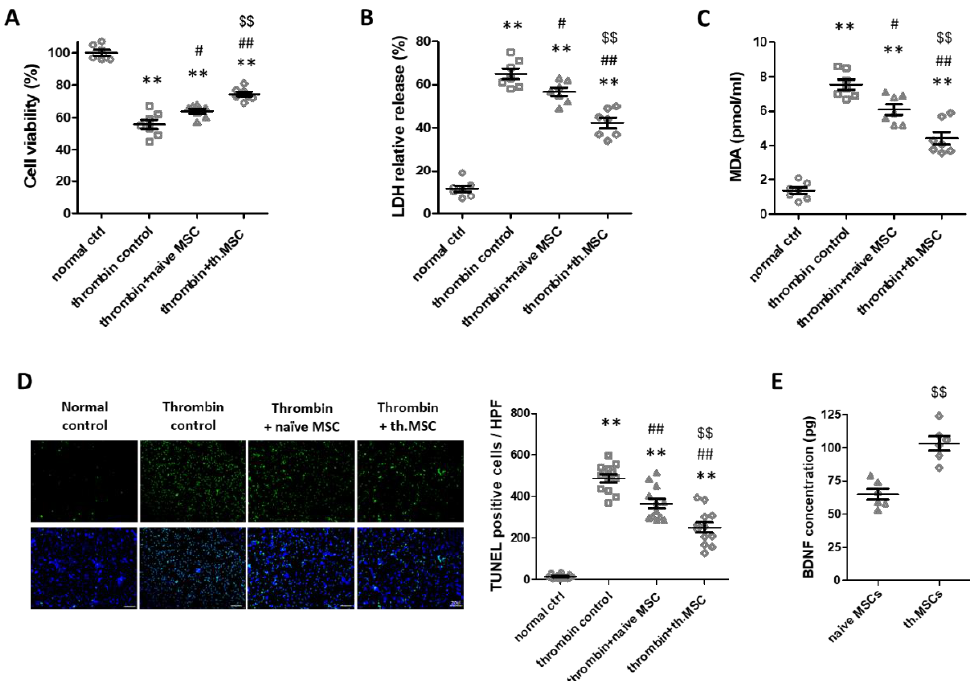
Figure 1. Effect of thrombin preconditioning on the neuroprotective efficacy of MSCs in the in vitro thrombin-induced neuronal injury model. ( A – C ) Cell viability, expressed as the relative prolifera- tion rate (%) to the normal control, cytotoxicity, expressed as the relative LDH level, MDA level, ( n = 7/group) and ( D ) the number of TUNEL-positive cells captured using florescent microscopy (green: original magnification; ×400, scale bars: 20 μ m) evaluated in the rat primary cultured cortical neurons 24 h after co-culture with naïve or thrombin-preconditioned MSCs ( n = 12/group). The enlarged images are shown in Supplementary Figure S2 (see Supplementary Materials) ( E ) BDNF protein levels measured in culture medium of naïve MSCs and thrombin-preconditioned MSCs. All the in vitro analyses were performed using MSCs prepared at one time ( n = 6/group). Data are expressed as means ± SEM. ** p < 0.01 compared to the normal control group, # p < 0.05 and ## p < 0.01 compared to thrombin induction control group, $$ p < 0.01 compared to thrombin induction with naïve MSC treatment group. BDNF, brain-derived neurotrophic factor; LDH, lactate dehydrogenase; MDA, malondialdehyde; MSCs, mesenchymal stem cells; SEM, standard error of the mean; TUNEL, terminal deoxynucleotidyl transferase dUTP nick end labeling.